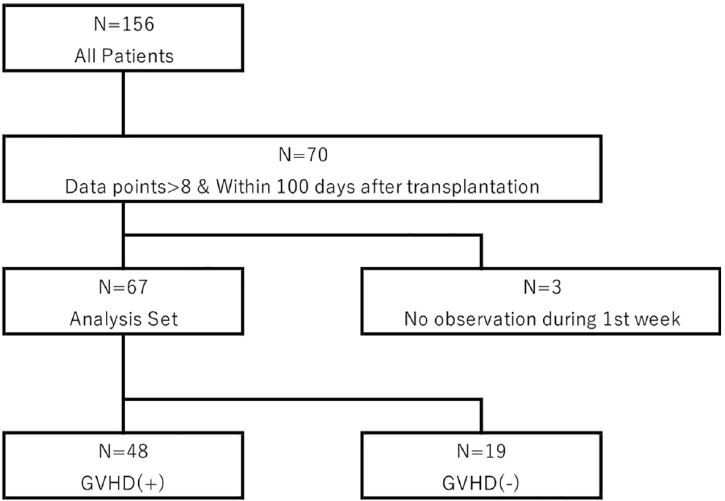
Fig 1. Patient disposition. From 156 patients analyzed for sDNAM-1 in the sera, we finally included 67 in our study. Details of the inclusion criteria are given in the Materials and Methods.